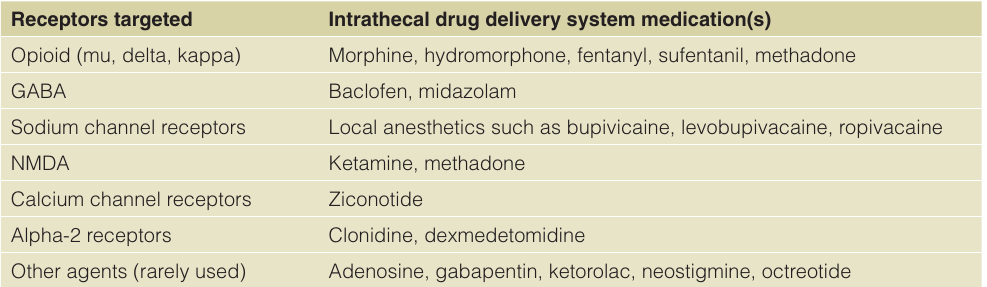
Table 2. Receptor targets for pain medications 2 .